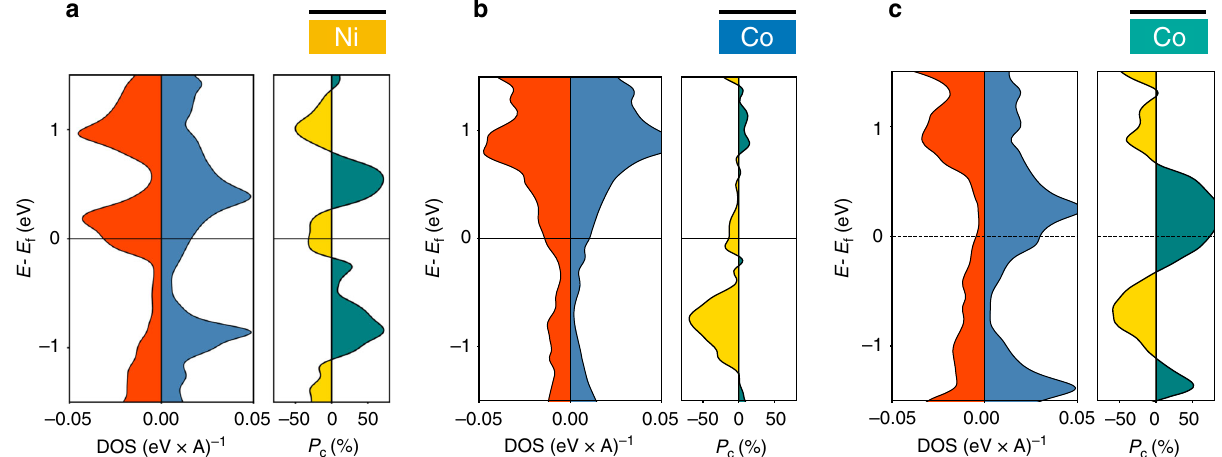
Fig. 6 Spin-dependent band calculations for different electrodes taken independently. In all panels, the density of states (DOS) projected on graphene is represented in blue (red) for majority (minority) spins plotted against energy ( E ) relative to Fermi energy ( E F ). Positive (negative) spin polarization ( P c ) of the hybridized/proximitized graphene layer is depicted in turquoise (gold). First, isolated interfaces alone have been calculated for a Ni/Gr, b Co/Gr, and c Co/Gr with a strong epitaxial interaction. Negative spin polarizations are derived in a and b cases, as expected from theoretically described spin fi ltering effects at FM/Gr interfaces. This is in-line with the negative spin polarization measured from Fig. 2 where Ni(111)/graphene is isolated from Co by the Al 2 O 3 tunnel barrier.